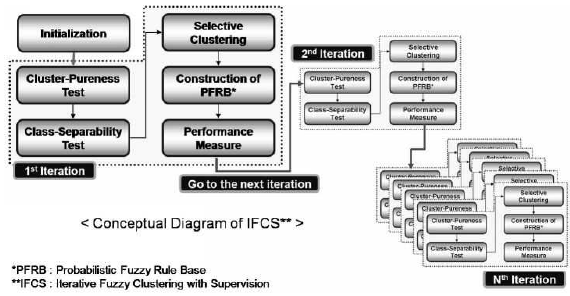
Fig. 15. Learning procedure of IFCS (Iterative Fuzzy Clustering with Supervision)